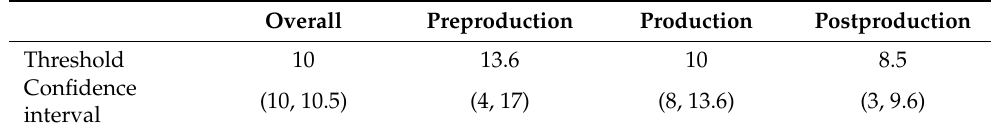
Table 5. Threshold estimation results and confidence intervals.